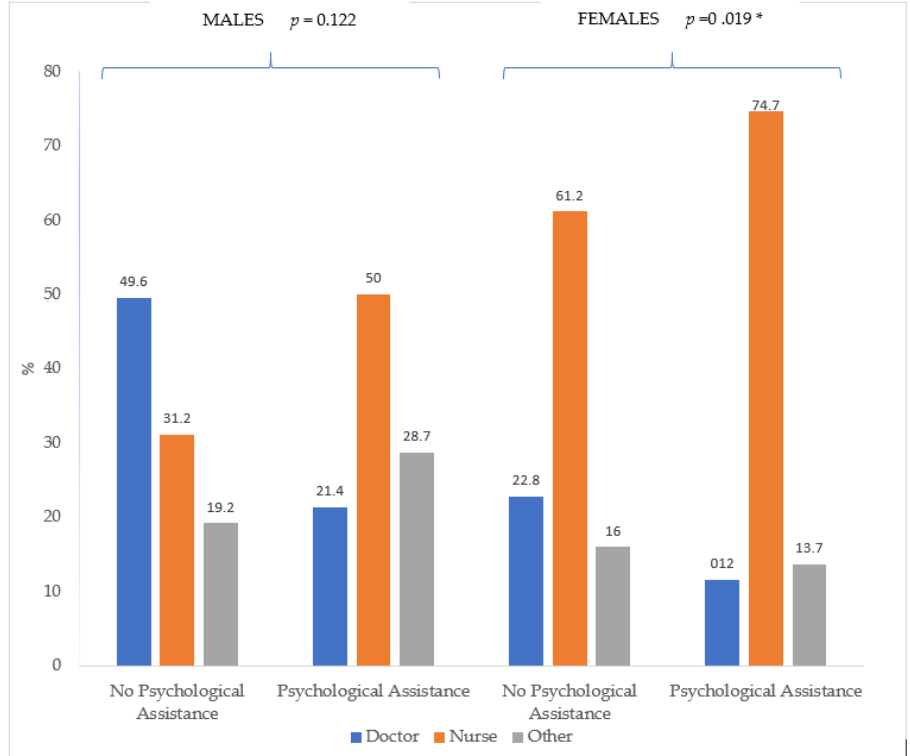
Figure 1. Candidates for psychological assistance according to professional activity and gender variables. * p > 0.001.